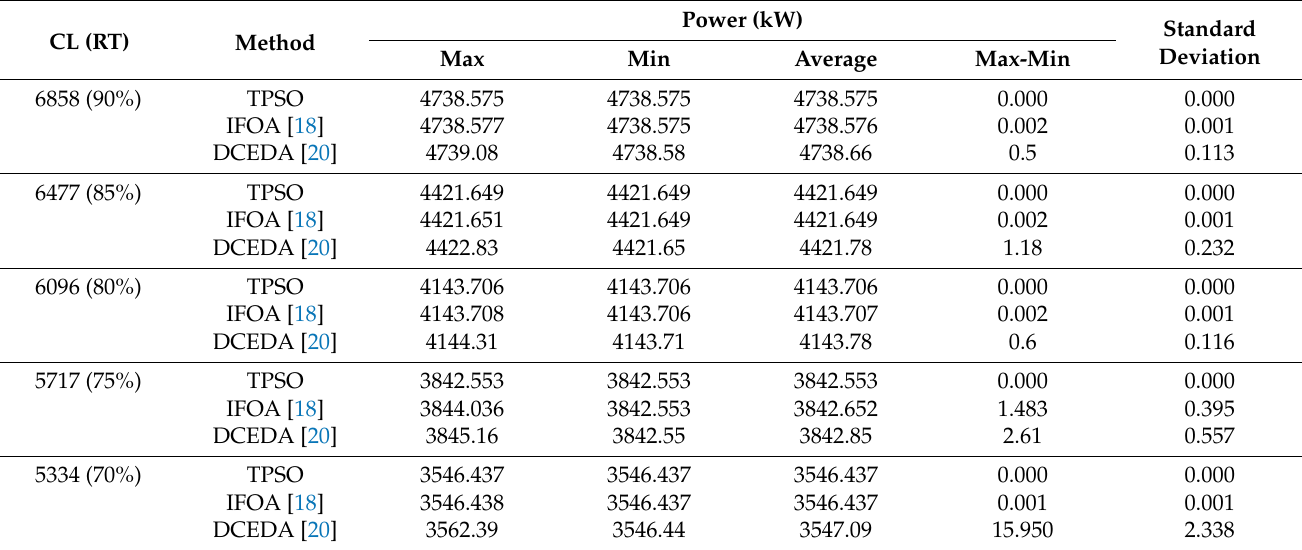
Table 16. Comparison of stability yielded by TPSO, IFOA and DCEDA in Case 1.